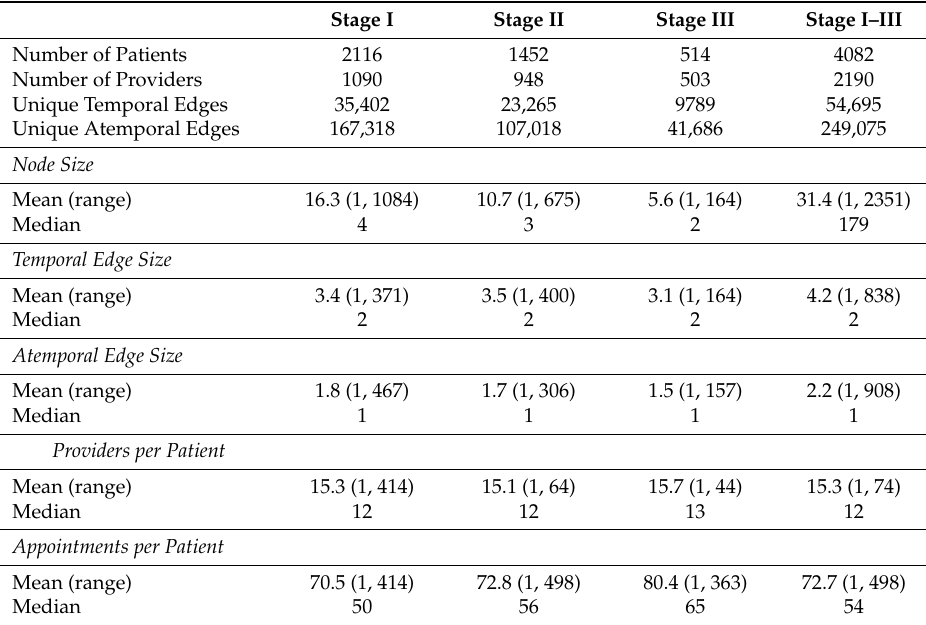
Table 2. Outpatient network statistics by cancer